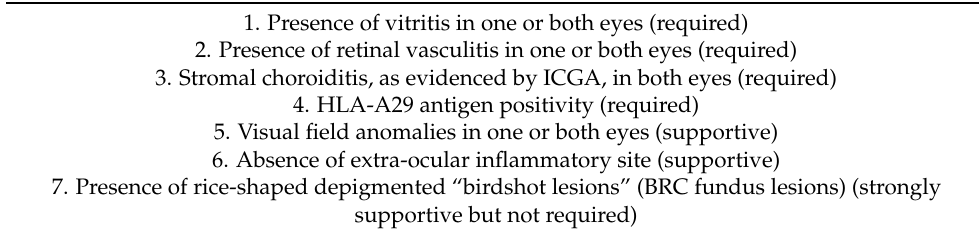
Table 1. European based simplified diagnostic criteria for BRC *